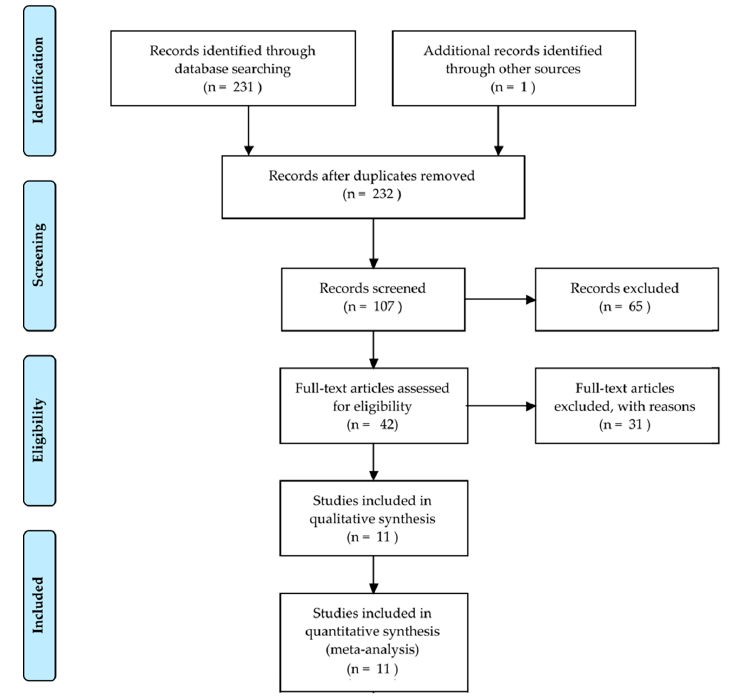
Figure 1. PRISMA flow diagram to describe the study selection.